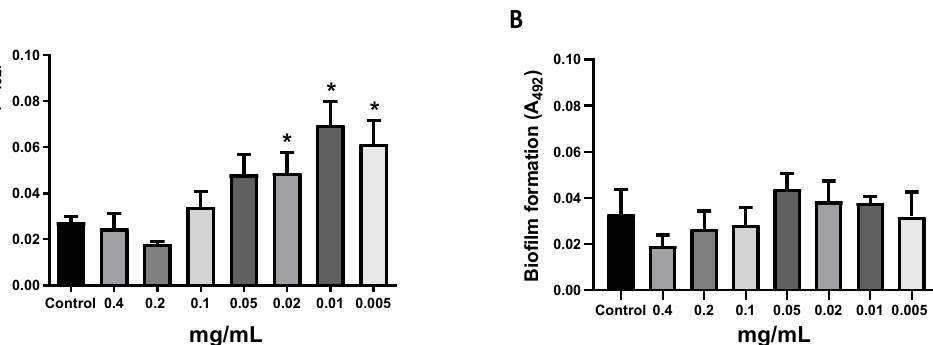
Figure 1. Biofilm formation induced by neutrophil protein extract. Total proteins were obtained from neutrophils and HaCaT cells, and the protein concentration was determined by Bradford. A bacterial culture from overnight incubation was diluted 1:200 and cultured with different concentrations of the neutrophil’s protein extract ( A ) and HaCaT protein extract ( B ) and the amount of biofilm formation was determined by the Christensen’s et al. method. Asterisk * indicates a significant difference ( p < 0.05) concerning the control (bacteria without protein extract). The statistical analysis was performed using a one-way ANOVA with a Tukey’s test. Table 2. Biofilm formation in S. epidermidis isolates in the presence of neutrophils’ proteases. Isolates ( n = 53)